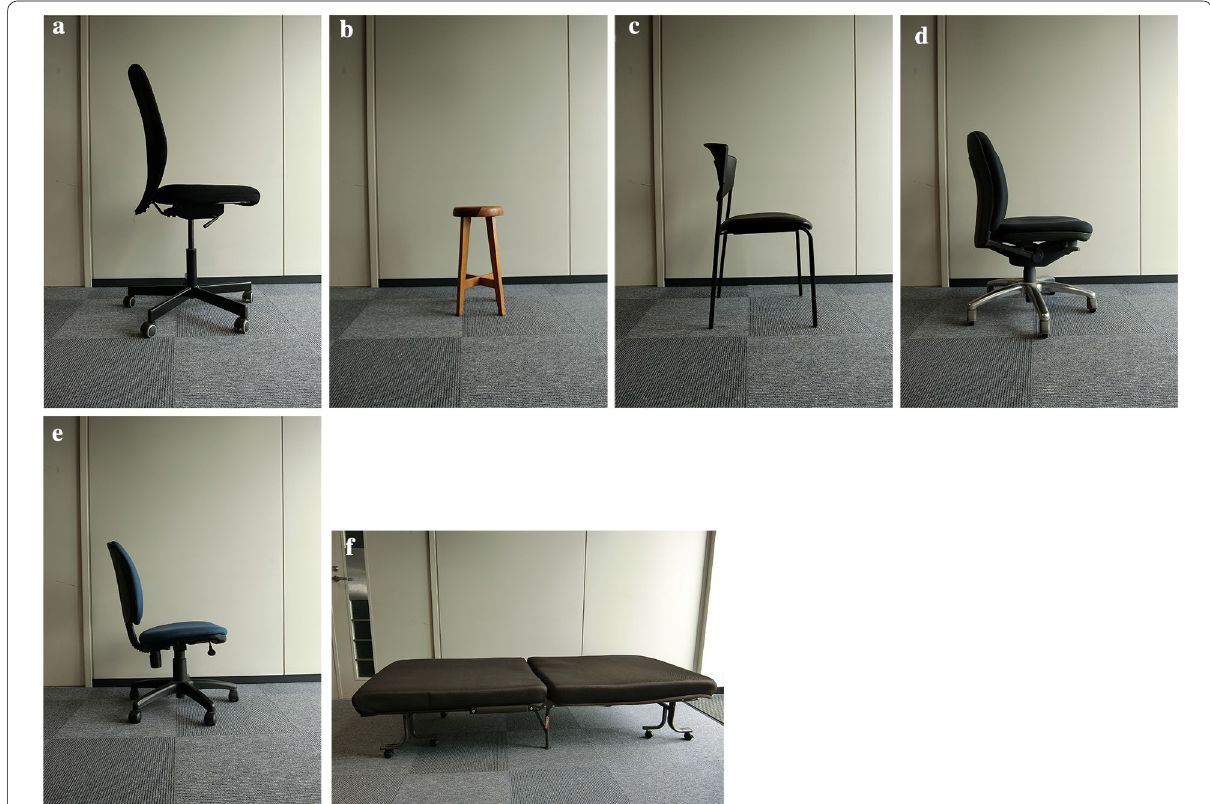
Fig. 10 Pictures of chairs and a bed. a Chair 1; b chair 2; c chair 3; d chair 4; e chair 5; f